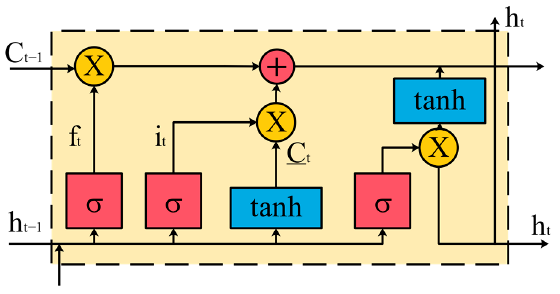
Figure 1. The network structure diagram of LSTM.